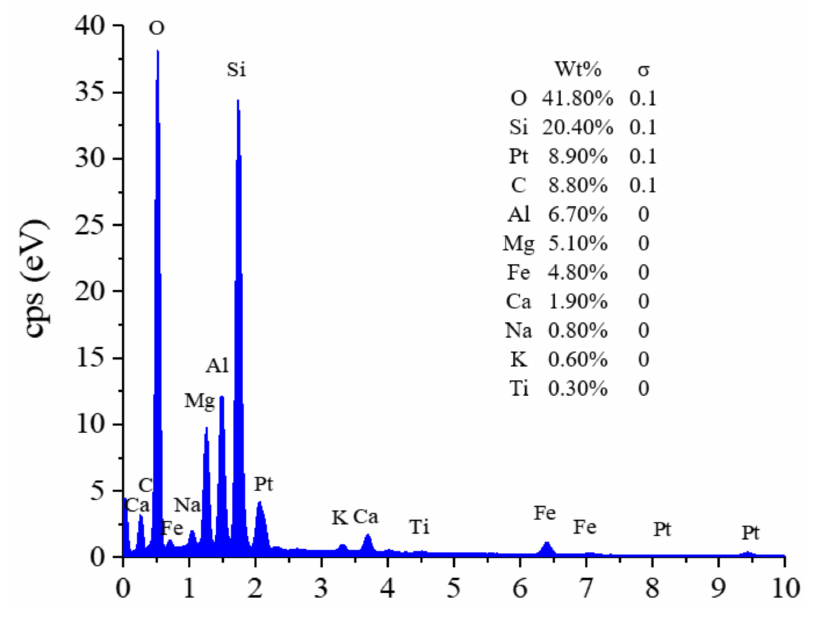
Figure 1. EDS energy spectrum.